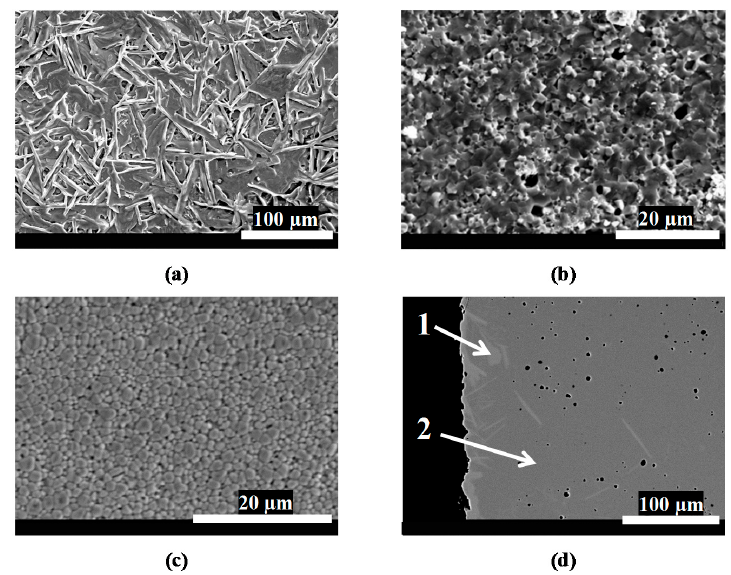
Figure 8. SEM micrographs of BCZN ceramics ( S2 ): ( a ) of a surface; ( b ) of a fractured surface; ( c ) of a grain boundary; and ( d ) of a longitudinally polished section.